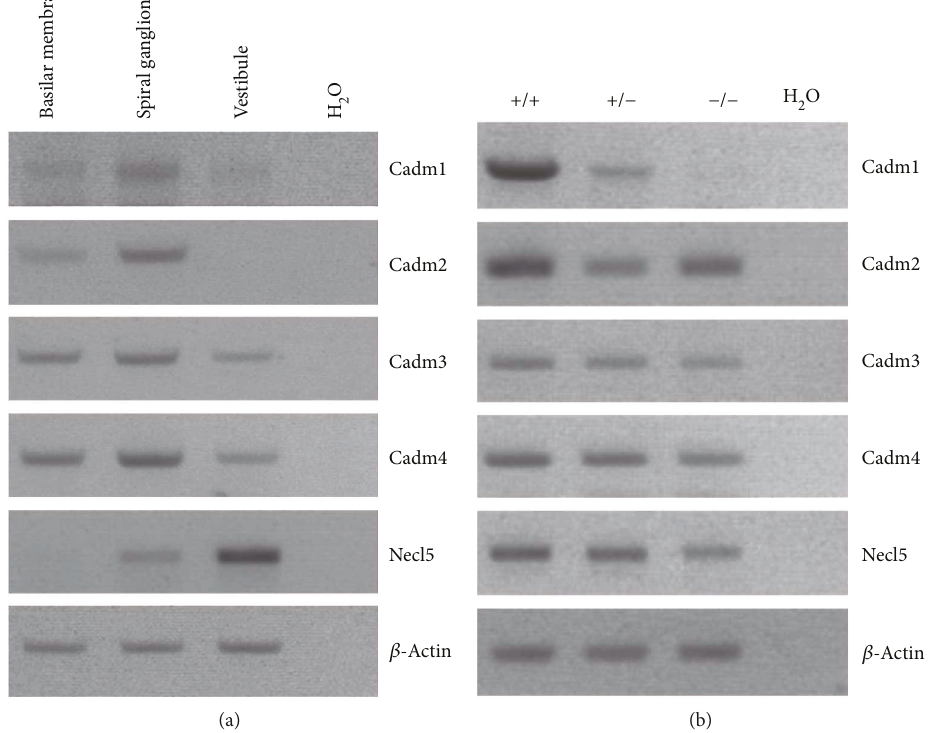
Figure 5: Expression of Necl family members in mouse inner ear. Total RNA from postnatal day 2 (P2) mice was extracted and reverse-transcribed into cDNA, which was then used as PCR template to examine the expression of Necl family members. (a) Expression of Necl family members in basilar membrane, spiral ganglion, and vestibule of wild-type mice was examined through RT-PCR. (b) Expression of Necl family members in the inner ear of Cadm1 knockout mice was examined through RT-PCR. β -Actin was included as internal